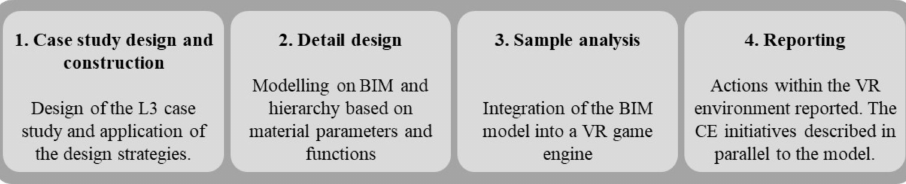
Figure 2. Methodological framework adopted in this study.